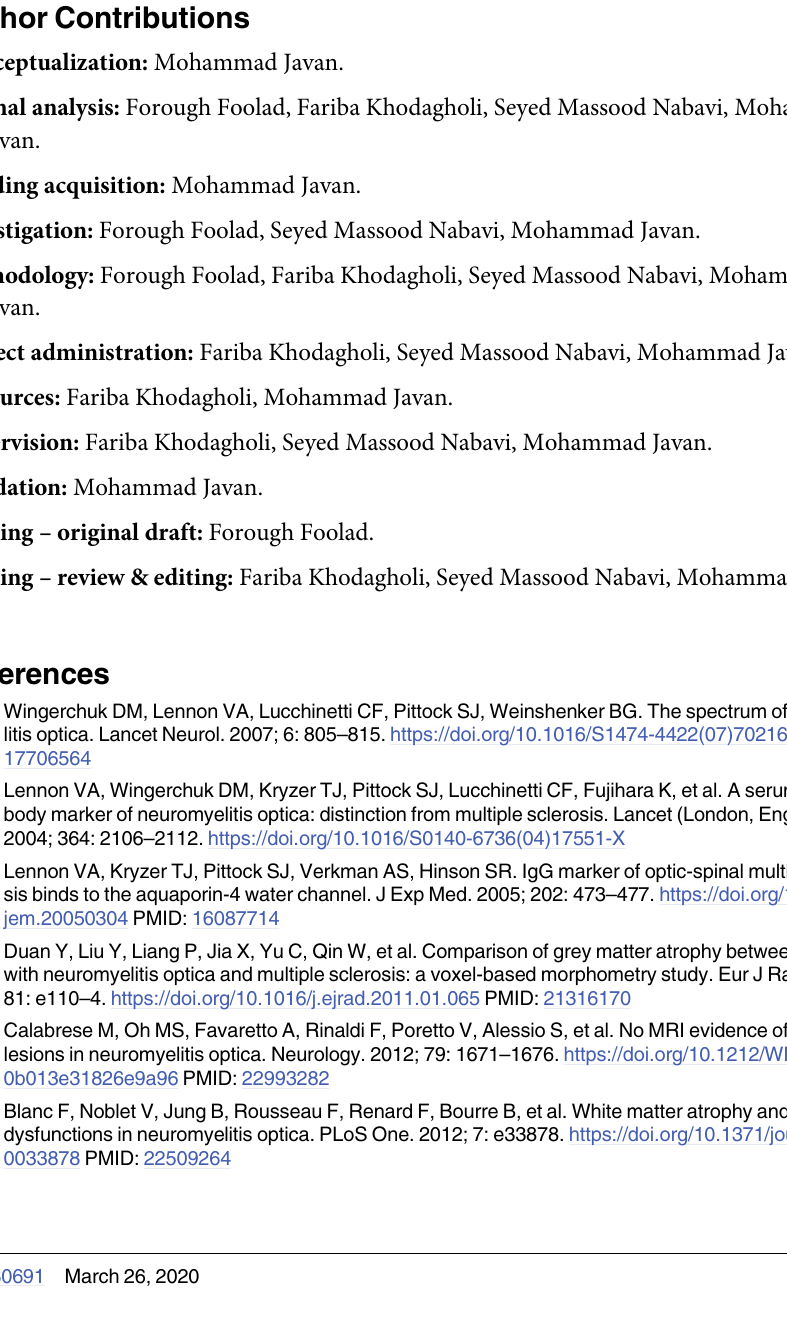
S1 Fig. The correlation Symbol Digits Modalities Test with the presence or absence of brain lesions in NMO patients. 0 = Absence of brain lesions, 1 = Presence of brain lesions. (PDF) S2 Fig. Device prepared for nine hole peg test (9-HPT) as set for checking the patient per- formance with right hand. (PDF) S3 Fig. A picture from form prepared for Symbol Digit Modalities Test (SDMT). The num- bers (1 to 9) in patients native language, Persian, were matched with different